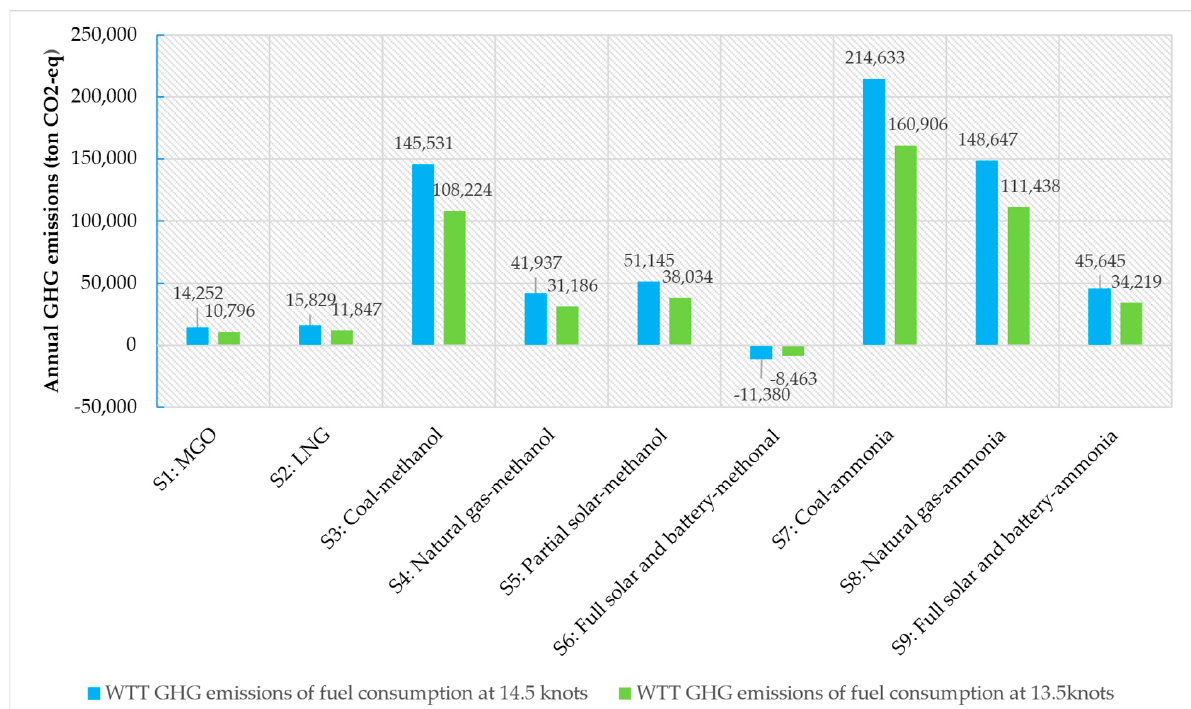
Figure 4. Annual WTT GHG emissions based on annual fuel consumption.